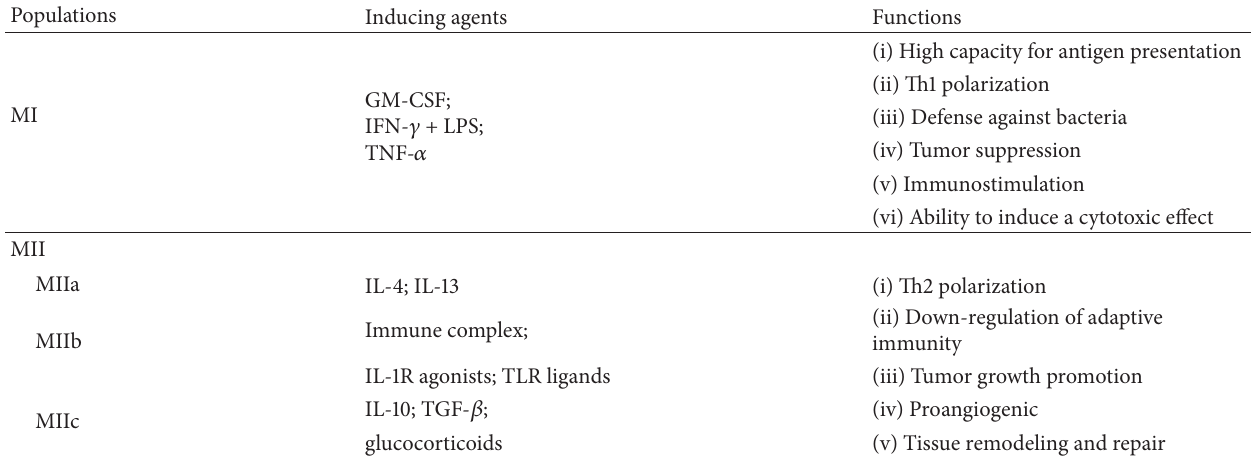
Table 1: Macrophage